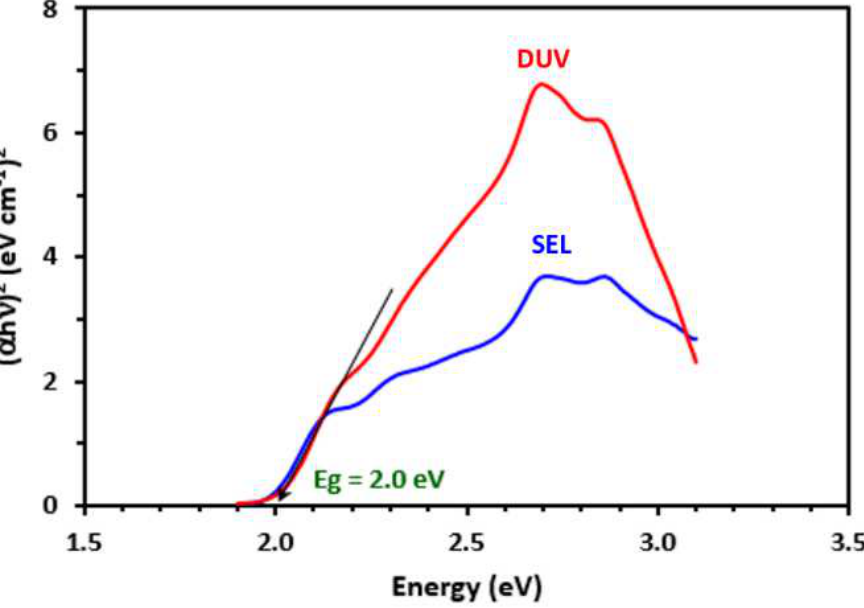
Figure 4. Tauc plots of energy (eV) against ( α h υ ) 2 for the CTC of DUV and SEL with DDQ in meth- anol.